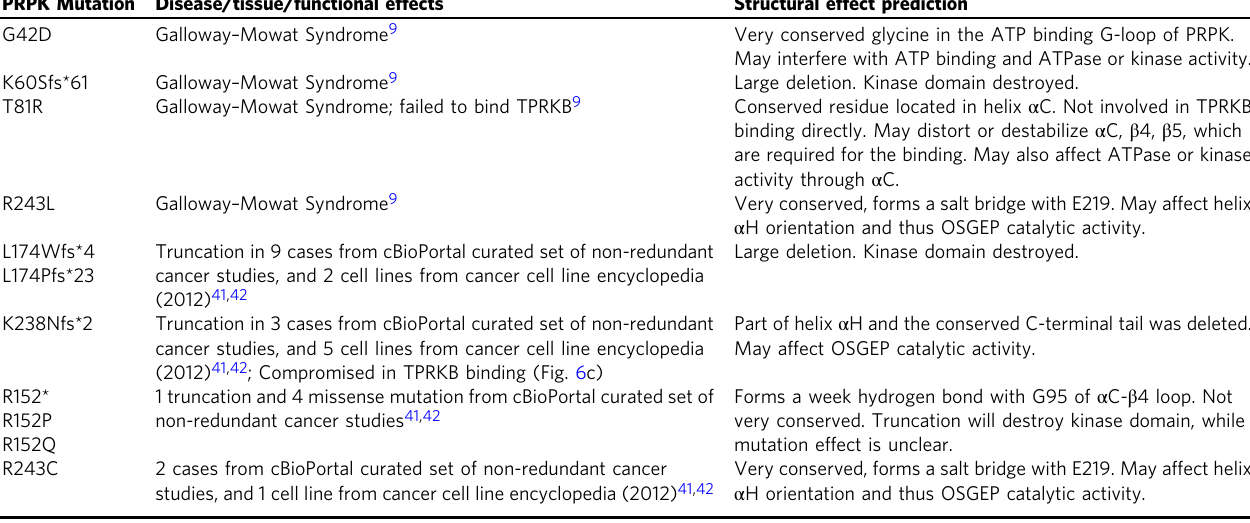
Table 1 Disease mutations of human PRPK.